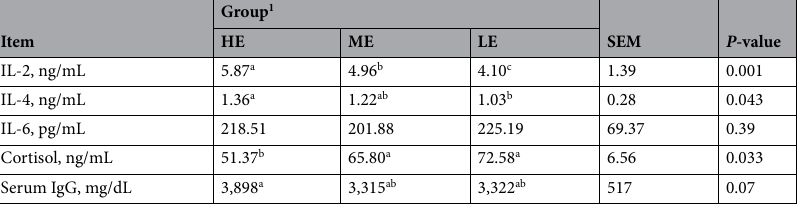
Table 4. Effects of prepartum maternal energy density on the serum immune indexes in neonatal calves. 1 HE = high energy (NEm = 1.67 Mcal/kg of DM); ME = medium energy; (NEm = 1.53 Mcal/kg of DM); LE = low energy (NEm = 1.39 Mcal/kg of DM). a,b ,c Means bearing different superscripts in the same row difer significantly (P < 0.05).